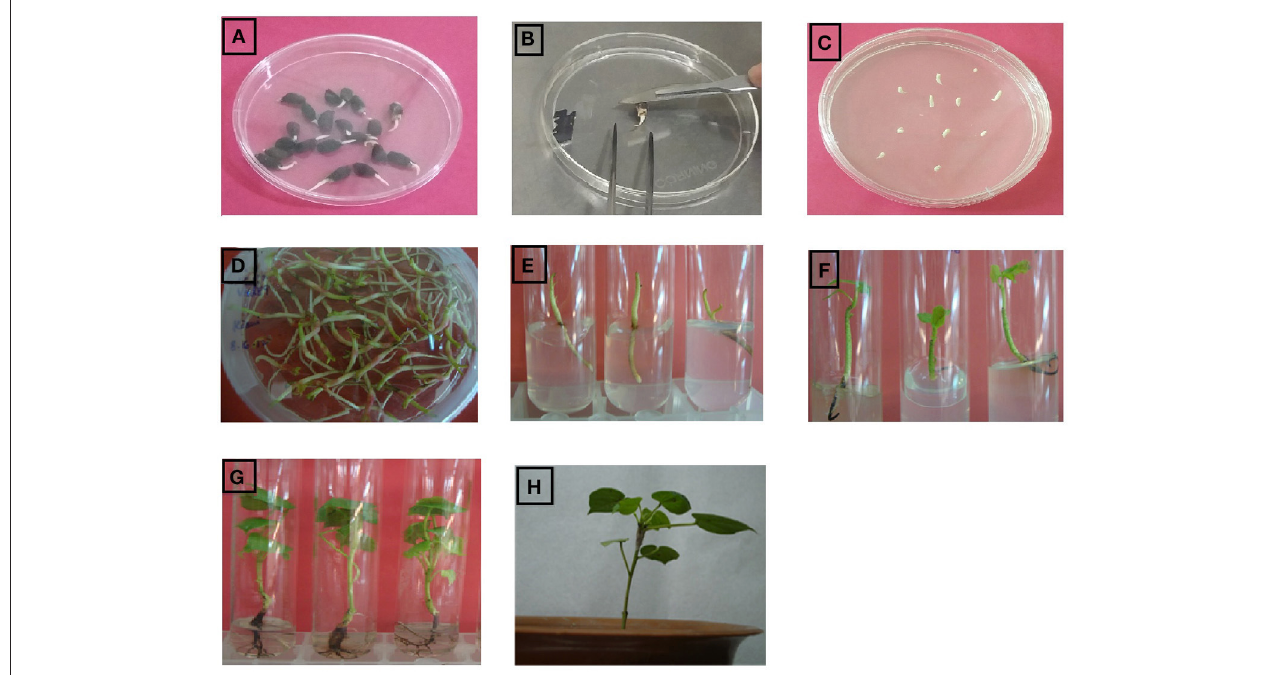
FIGURE 1 | Complete protocol of agrobacterium mediated transformation in cotton plant embryos. (A) germinated cotton seeds, (B) isolation and injuring of cotton embryos, (C) Agrobacterium treated embryos on MS medium, (D) Agrobacterium treated embryos on MS medium after 3 days, (E) implantation of cotton embryos in test tube containing MS medium with kanamycin, (F) shoot growing on MS medium containing kanamycin selection, (G) root development on MS rooting medium, (H) transgenic cotton plants shifted to soil for acclimatization.